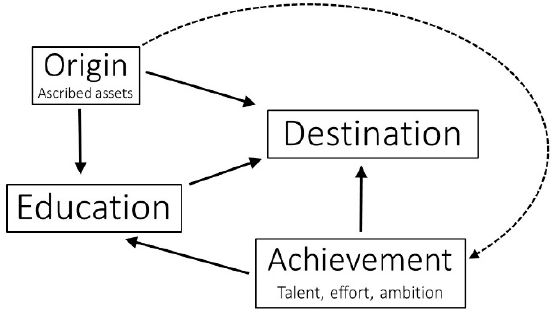
Figure 1. Origin-Education-Destination triangle.